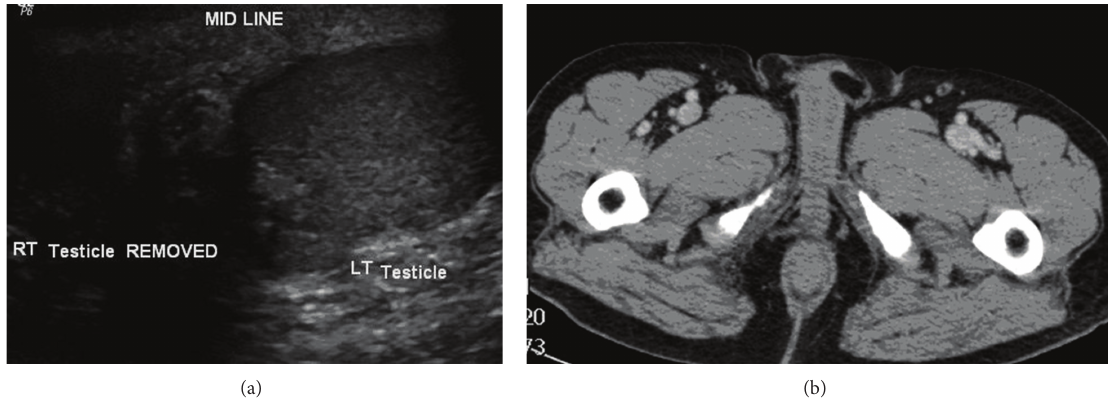
Figure 3: Follow up US and CT scans (a and b) showing no evidence of local